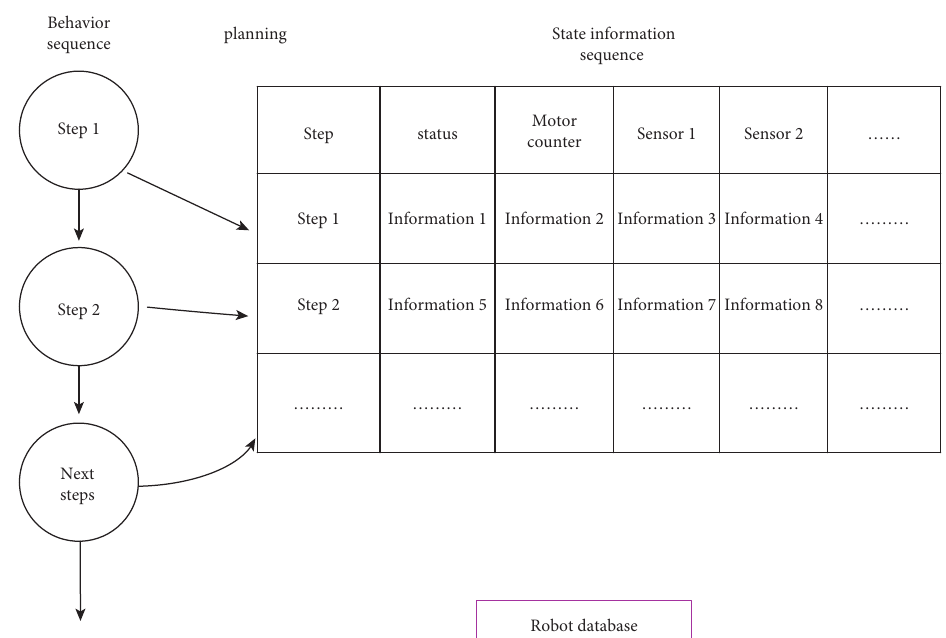
Figure 10: FSM design for damper replacement